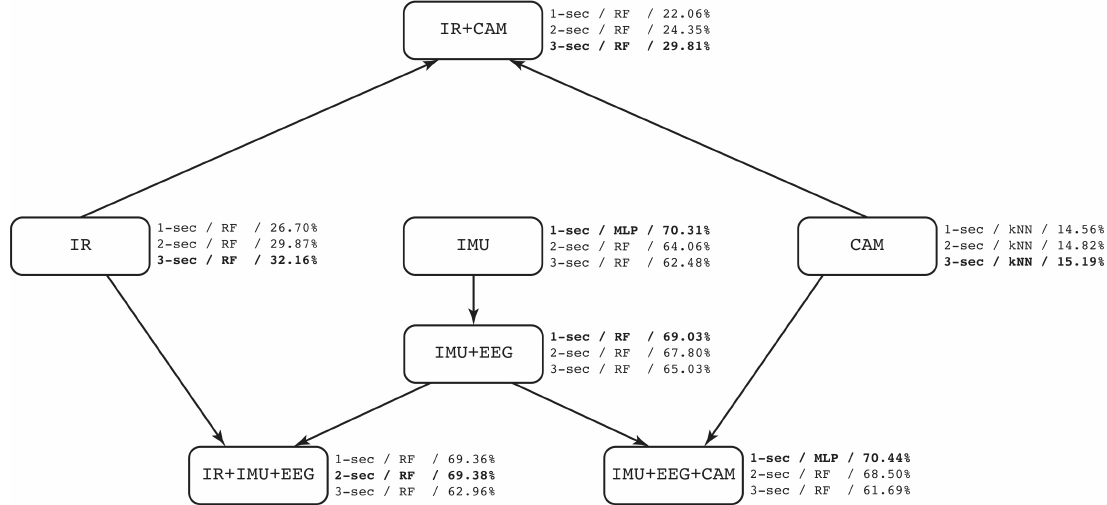
Figure 15. Graphical description of the different modalities. Information comprises: window size/best ML-model/mean F 1 -score. Bold text represents the best performance. Table 14. The best performance (mean ± standard deviation) obtained for each modality depending on the ML-model. The best window size is written in